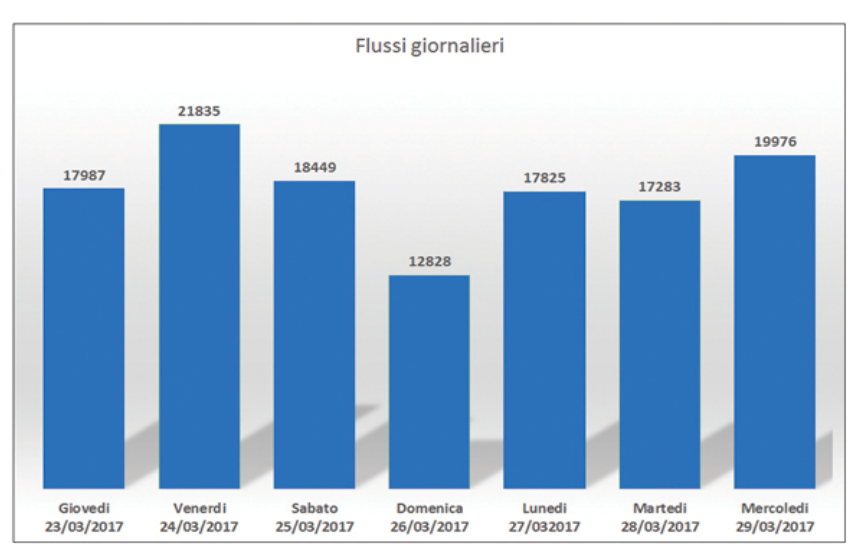
Figure 3. Comparison streams for time slots.